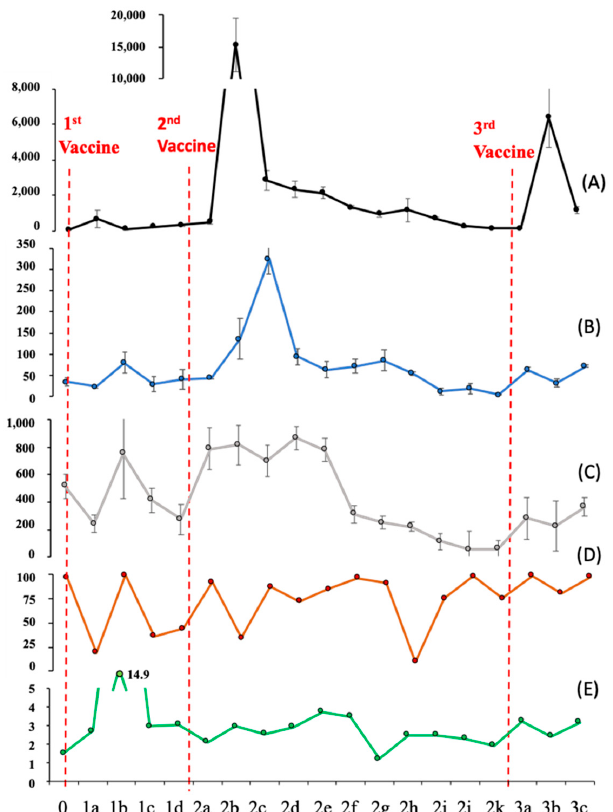
Figure 5. The results of continuous monitoring of the concentration of neutralizing IgG ( B ) and sIgA ( C ) antibodies, antioxidant activity ( D ), and protein concentration ( E ) in saliva and neutralizing IgG concentration in serum ( A ) before and after 1st, 2nd, and 3rd vaccinations in the same individual over time were compared vertically. The abscissa represents the date and time of sampling. 0: at